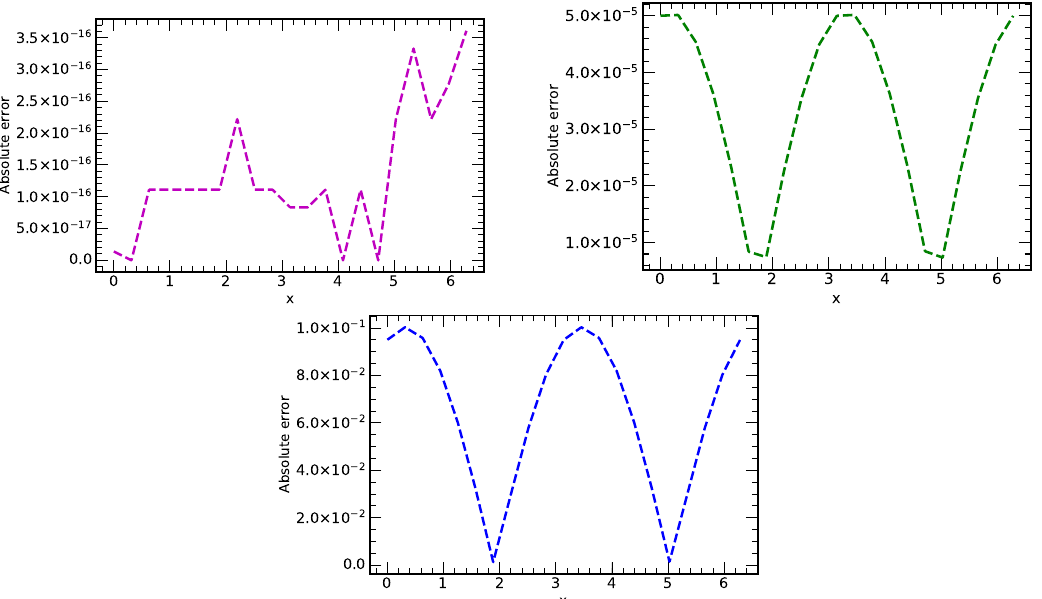
Figure 2. Plots of absolute errors vs. x at different values of time ( t = 0.1,2.0,4.0) using the methods LADM, HPM and